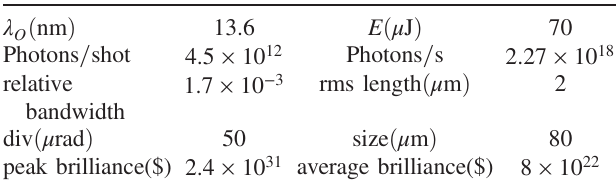
TABLE II. Characteristics of the seed, generated by the FEL oscillator with undulator length L w ¼ 9 m . The repetition rate of the source is 0.5 MHz. $ ¼ Photons = s = mm 2 = mrad 2 = bw ð ‰ Þ . λ ð nm O